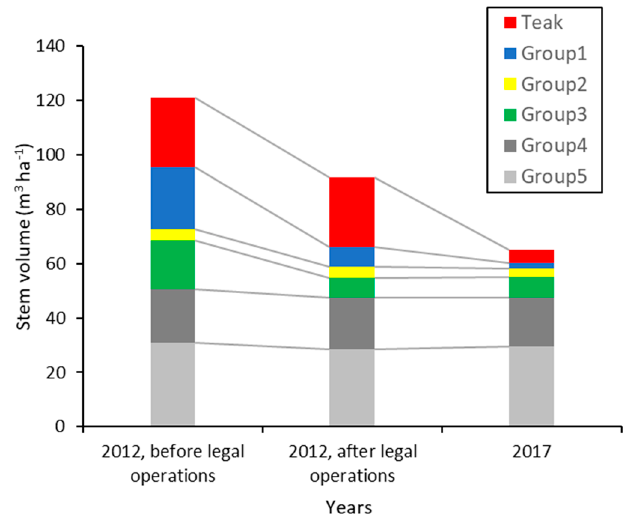
Figure 5. The volume of trees with a DBH ≥ 20 cm for each species group before and after the legal operations in 2012 and in 2017 in Compartment 93, South Zamaye Reserved Forest, Bago Yoma, Myanmar.